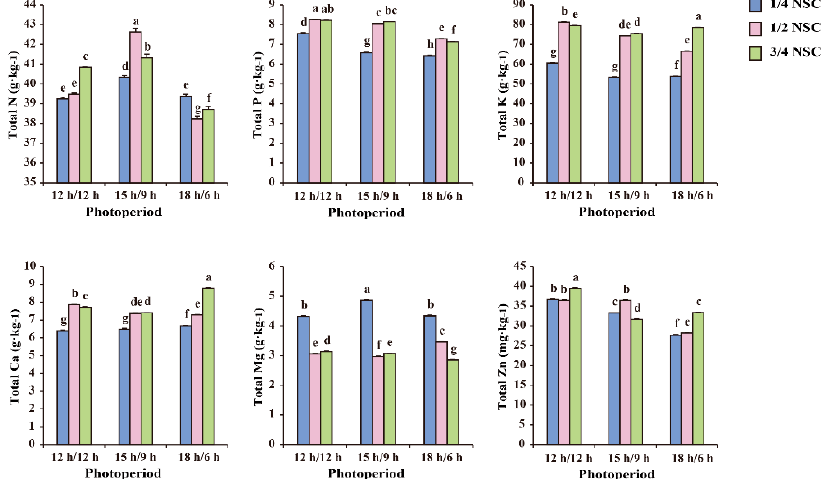
Figure 2. Total N, P, K, Ca, Mg, and Zn contents in lettuce under the interaction of photoperiod and NSC. The letters marked in all figures mean the significance of differences ( p ≤ 0.05, Tukey’s test).